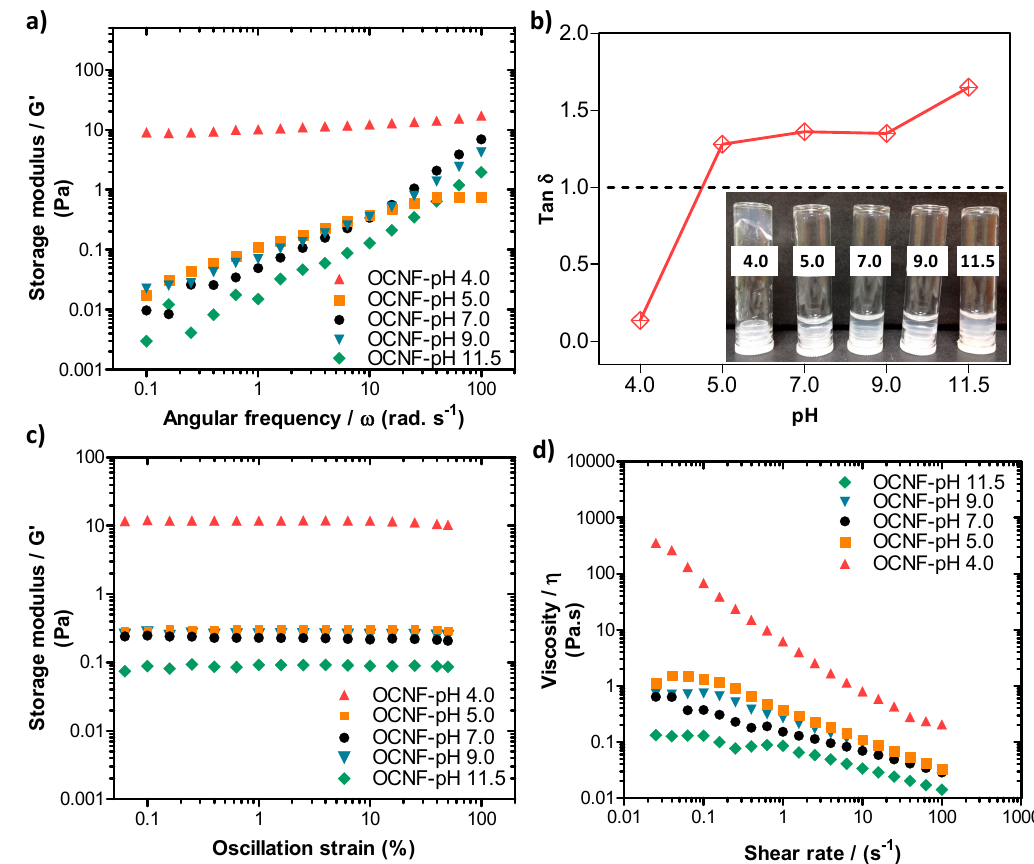
Figure 5. ( a ) Oscillatory frequency sweeps, ( b ) tan δ values, ( c ) amplitude sweeps, and ( d ) shear flow curves of OCNF (1 wt%) dispersions at various pH conditions (pH 4, 5, 7, 9, and 11.5). Inset in (b) is a photograph of the samples labelled by their pH.